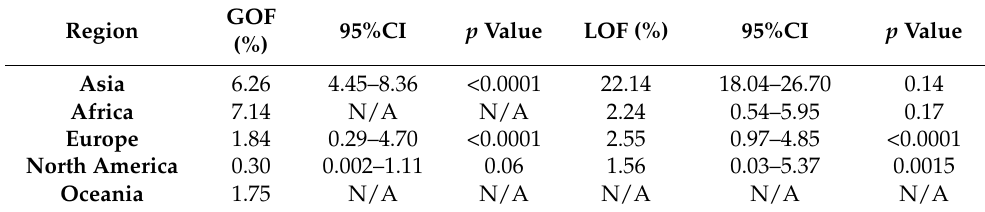
Table 2. The geographical analysis of PCSK9 mutation in